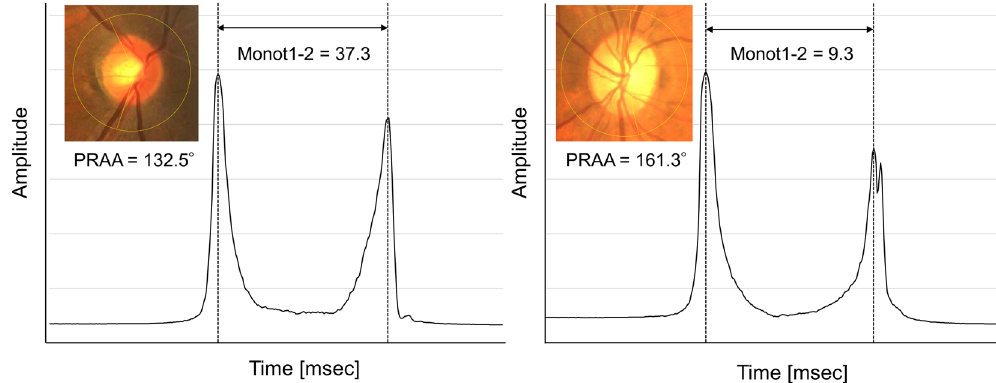
Figure 3. Measurement of Monot1-2 (left eye). Monot1-2 was estimated as the total length of retrogressive movement between applanation peak 1 and applanation peak. Left figure shows an example eye with long AL (51 years old, male, AL = 26.4 mm) with small PRAA (132.5°) and large Monot1-2 (37.3), whereas right figure is from a non-long eye (73 years old, female, AL = 23.44 mm) with large PRAA (161.3°) and small Monot1-2 (9.3). PRAA: peripapillary retinal arteries angle; AL: axial length.